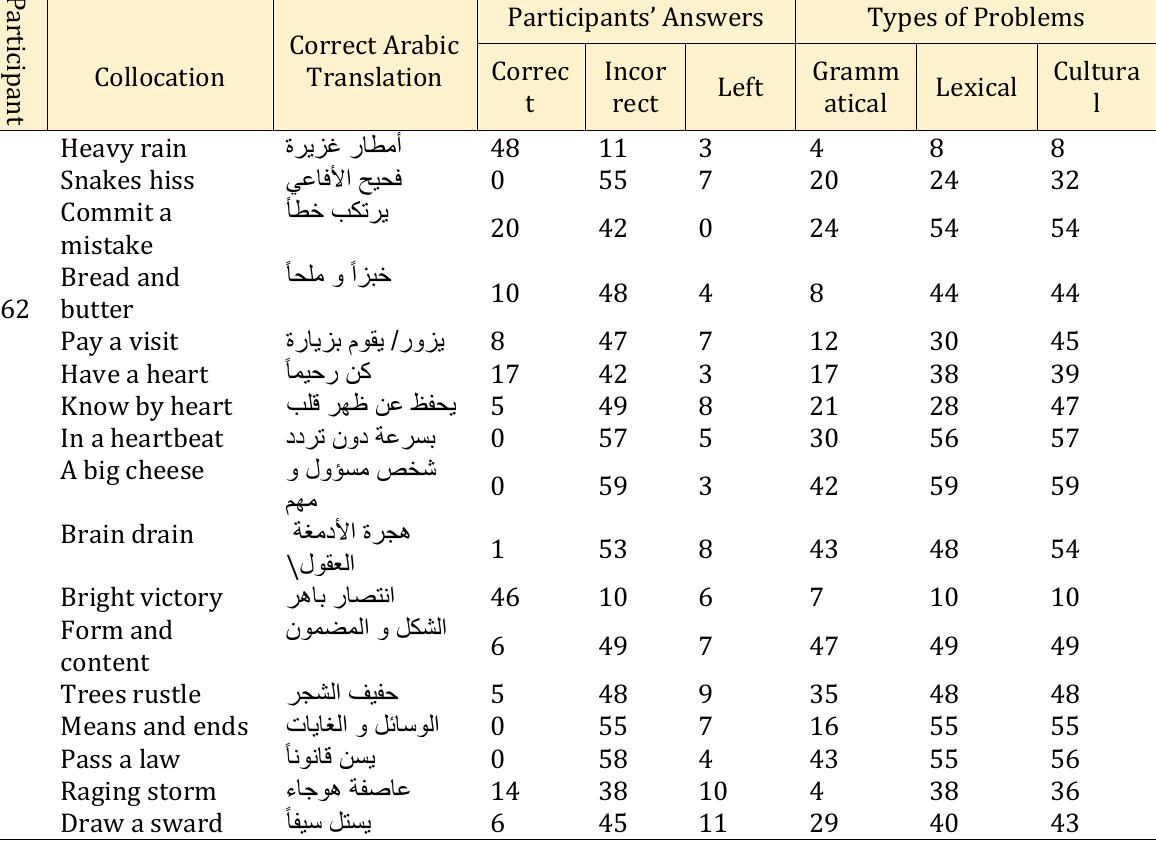
Table 2. Analyzing Students’ Answers in Translating English